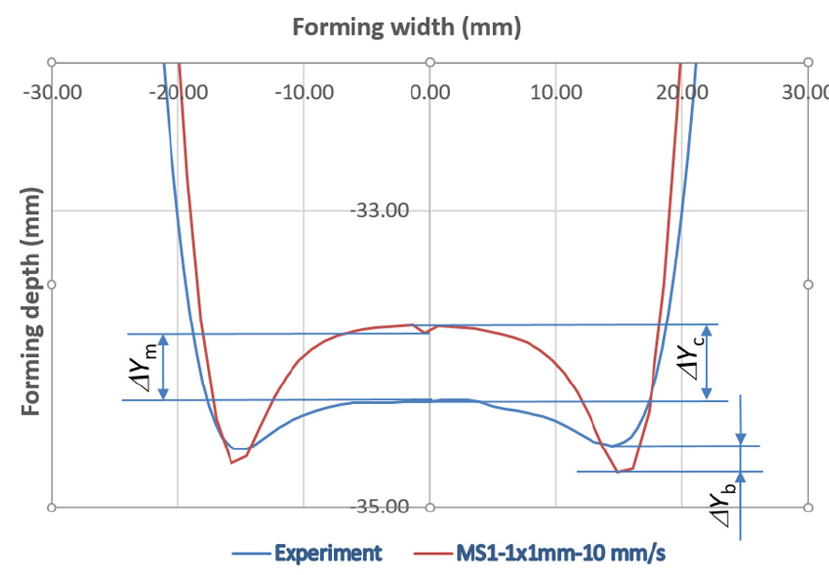
Figure 11. Comparison of experimental results with the results from the reference simulation of the pillowing effect (bottom part of the specimen only). Table 5. Calculation times and geometrical accuracy of simulated model versus the experimental part. Test